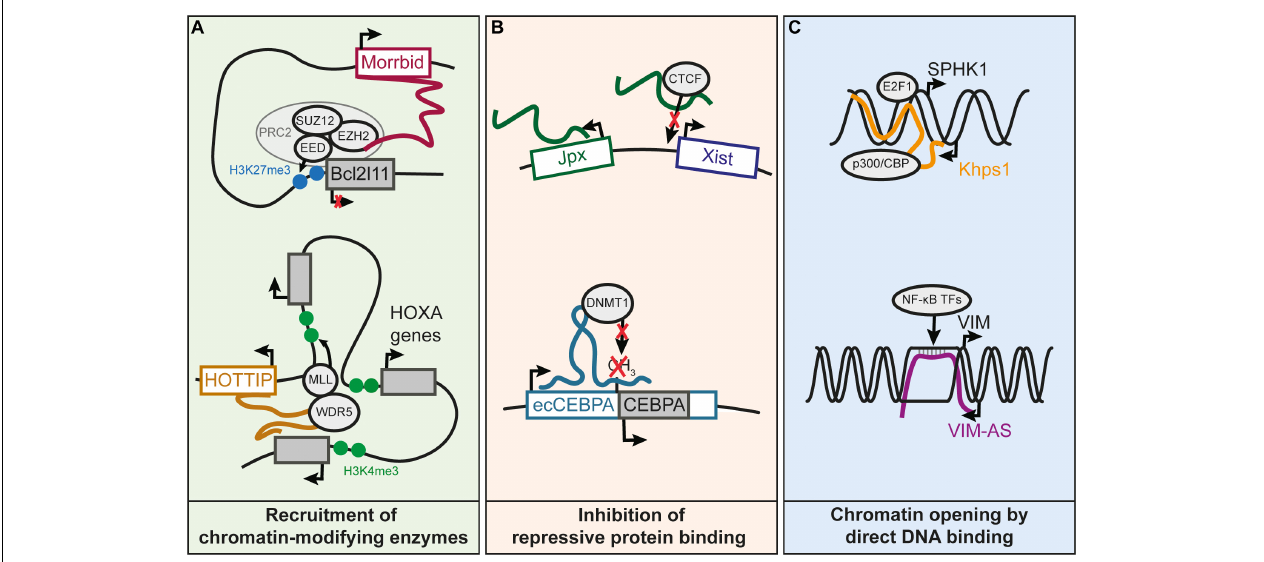
FIGURE 2 | Known molecular mechanisms underlying cis -regulation by lncRNAs. (A) Recruitment of chromatin-modifying enzymes by cis -regulatory lncRNAs. Morrbid represses the Bcl2l11 gene by recruiting the PRC2 complex to the Bcl2l11 promoter (Kotzin et al., 2016). HOTTIP recruits the WDR5 subunit of the MLL complex, resulting in the deposition of the H3K4me3 mark and subsequent activation of the HOXA distal genes (Wang et al., 2011). (B) LncRNA prevents binding of an inhibitory protein to a promoter, which results in gene activation. Jpx lncRNA competes with DNA for the binding of CTCF on Xist promoter, and this enables activation of Xist expression (Sun et al., 2013). Transcription of ecCEBPA, a sense-overlapping lncRNA of the CEBPA gene, prevents the silencing of CEBPA by inhibiting DNMT1-dependent DNA methylation of CEBPA promoter (Di Ruscio et al., 2013). (C) Increased chromatin accessibility by DNA binding of lncRNA. The Khps1 lncRNA forms a triple helix with the promoter of SPHK1 , which leads to the successive recruitment of p300/CBP and H3K27 acetylation of SPHK1 promoter, facilitating the binding of TFs on the SPHK1 promoter (Postepska-Igielska et al., 2015). VIM-AS lncRNA sustains the expression of the VIM gene by forming an R-loop at the VIM promoter (Boque-Sastre et al., 2015). The R-loop helps keeping the chromatin open, allowing TFs of the NF-kB pathway to bind to the VIM promoter and activate VIM